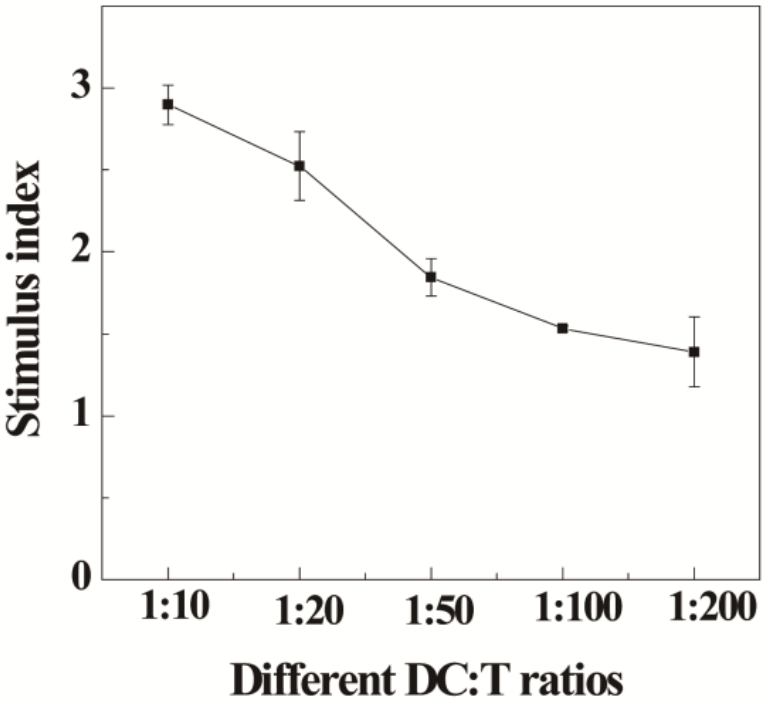
Figure 4. The proliferation result of T cells after co-culture with different ratio of mature BMDCs for 3 days by MTT assay.